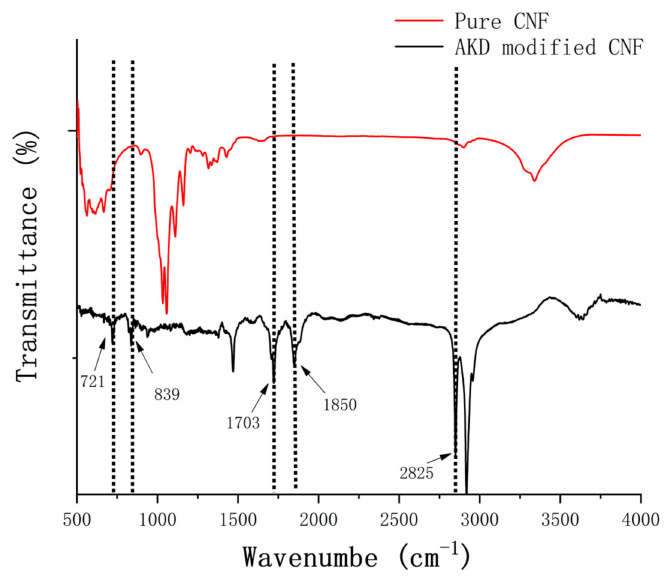
Figure 3. FT-IR spectra of CNF (top) and the AKD modified CNF